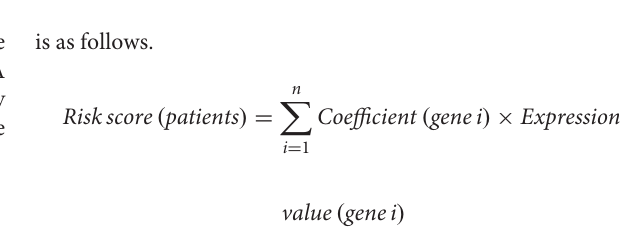
FIGURE 2 | Competitive endogenous RNA (CeRNA) network of Differential expressed RNAs. GDC RNA Tools was used to construct ceRNA network. CeRNA regulatory network was visualized by using Cytoscape software. The red color genes represent differential expressed long noncoding RNAs(lncRNAs). The blue represent differential expressed miRNAs. The pink represent differential expressed mRNAs. Strings indicated the interaction among these genes. hazard ratio (HR) value > 1 means that the gene is a high-risk gene, and HR < 1 means a low-risk